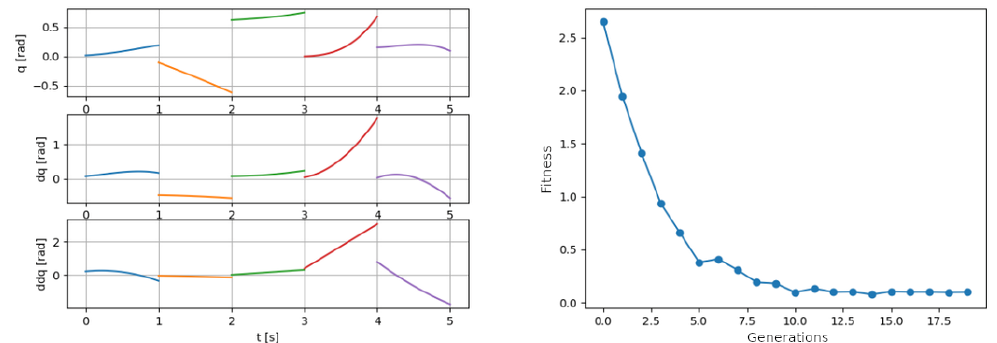
Figure 13. The achieved results for the GA with 10,000 candidate solutions trained for 20 generations. The best-achieved solution is visualized on the ( left ), and the fitness change through generations is on the ( right